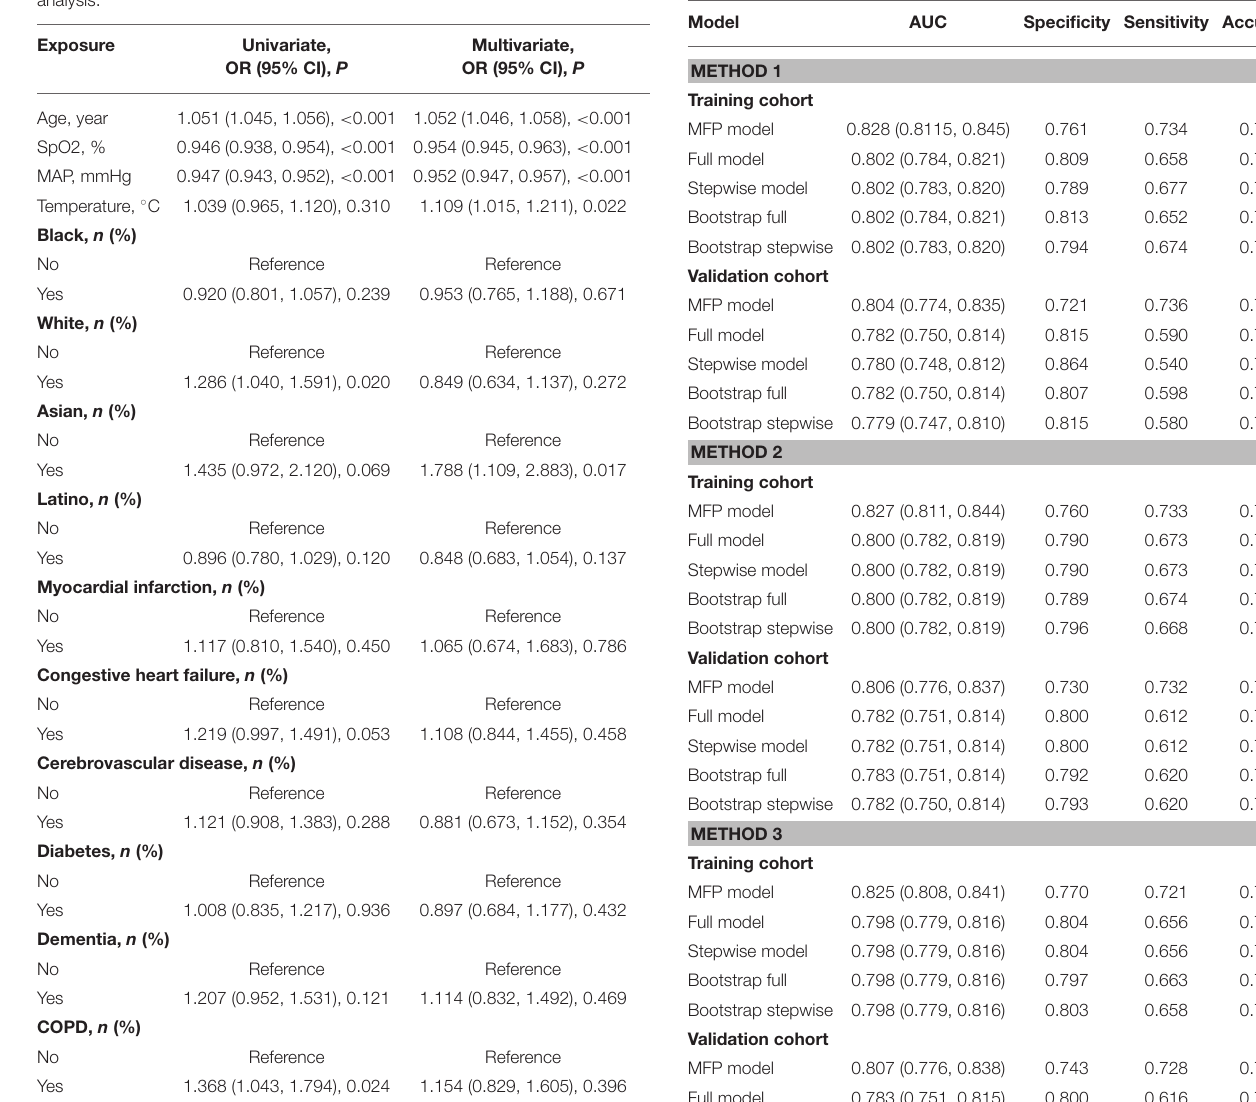
TABLE 3 | The construction and validation of prediction